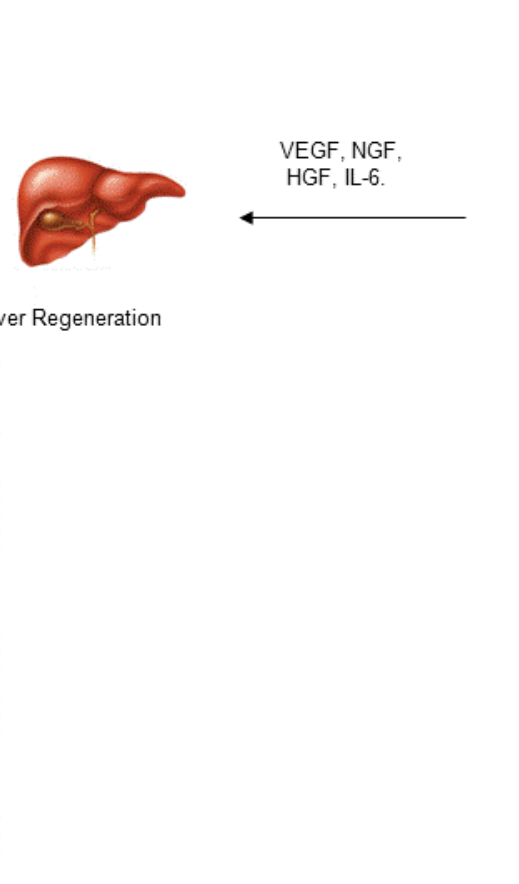
extrahepatic stem cells, including embryonic and adult (nonhepatic) stem cells, are able to differentiate towards the hepatic lineage[27]. In addition, the recent approach of reprogramming human differentiated cells into pluripotent cells, known as induced pluripotent stem cells (iPSCs), has opened a new era to obtain iPSC-derived hepatic